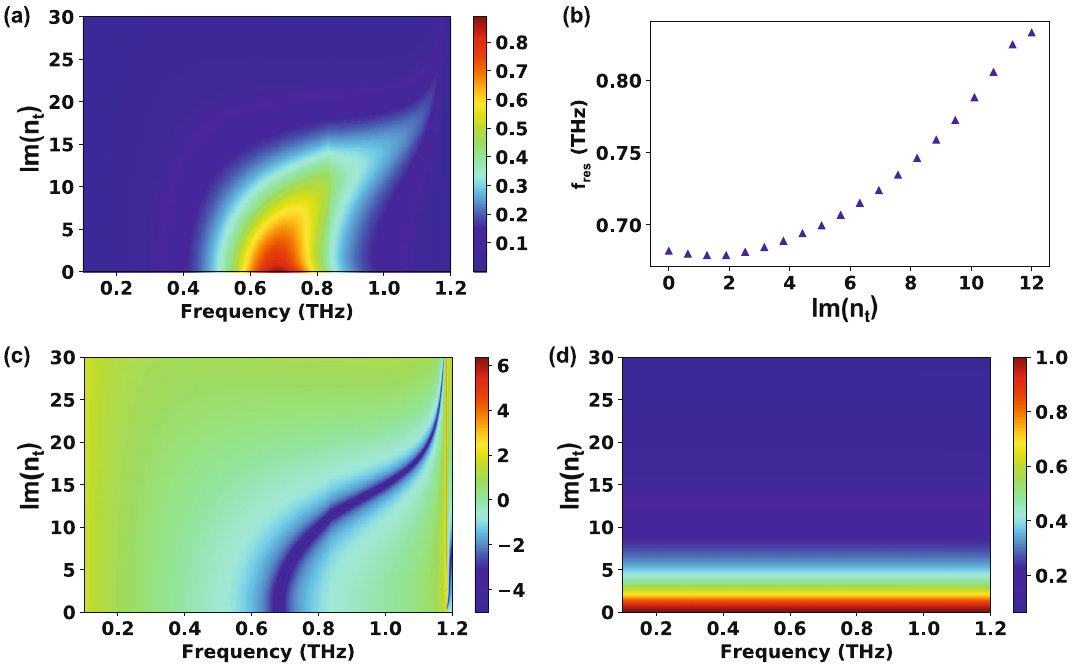
Figure 4. Effect of the imaginary part of the thin film refractive index ( Im ( n t ) ) on the transmission characteristics of a four-layer system. The geometry of the slot antennas: w = 25 µ m, l = 150 µ m, h = 70nm, p x = 127 µ m, p y = 180 µ m and d = 240 nm . The refractive index of the substrate is fixed at 2.0. ( a ) Transmission as functions of frequency and Im ( n t ) . ( b ) Relationship between the resonance frequency and Im ( n t ) . Im ( n t ) versus ( c ) log ( Im ( W 1 + W 3 )) and ( d ) 1